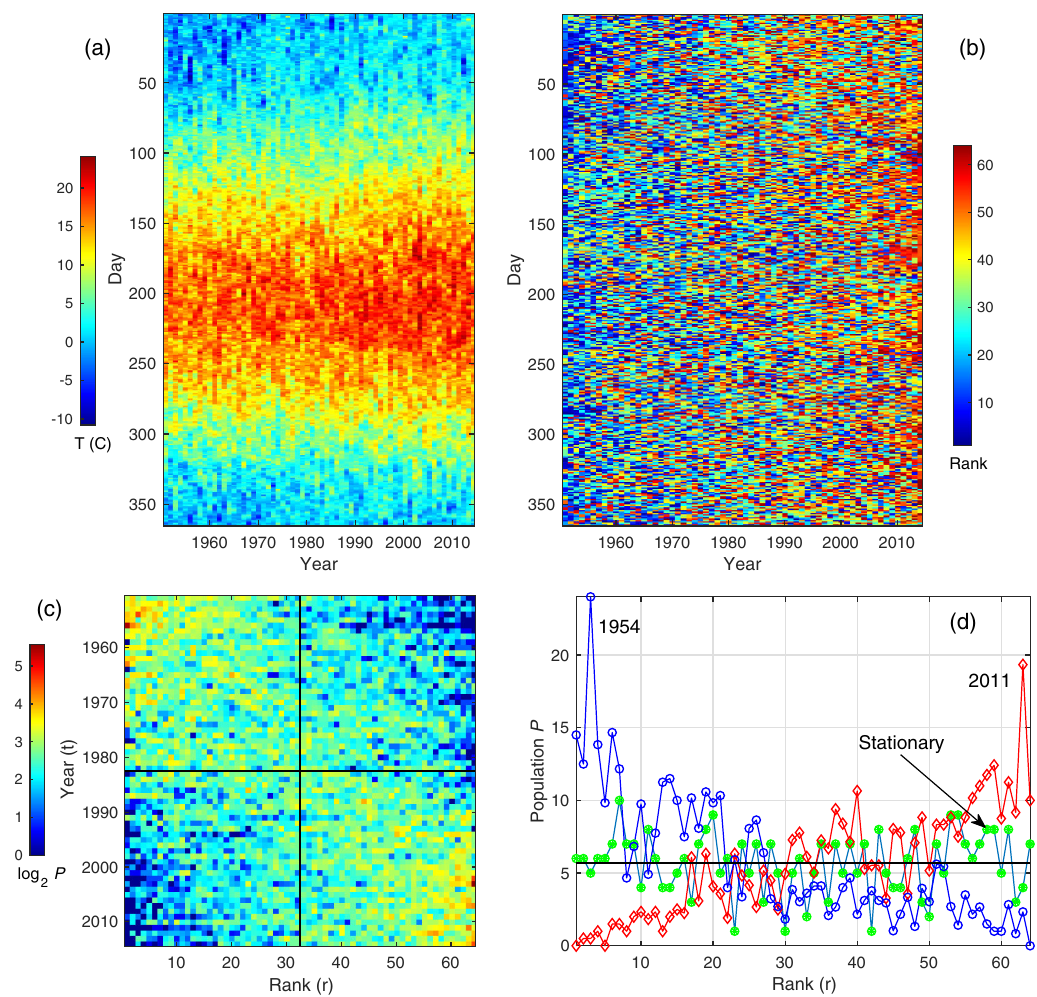
FIG. 1. Data processing, illustrated on weather station SZ000009480 (GHCN) Lugano, Switzerland. (a) Daily high-temperature values displayed as a day (row) and year (column) matrix. (b) Same data but with only the daily rank recorded in rows. (c) The 64 × 64 rank-year square matrix P , where each entry is the color-coded number of occurrences of that particular rank in that year ( “ occupation number ” ). The combined population of upper-left and lower-right quadrants (defined by the crosshairs) is 14 083, whereas the combined population of the lower-left and upper-right quadrants is 9277, with the expected population for stationary climate ð 365 × 64 Þ = 2 ¼ 11 680 . This quadrupolar asymmetry constitutes a warming signal. (d) 1954 and 2011 population vs rank. The near reflection symmetry between the red (diamond) and blue (circle) curves is evident and compatible with warming, with 75% of the 1954 population in the bottom half of ranks and 75% in the top half for 2011. The 1954 and 2011 maxima are at ranks 3 and 63, respectively. Considering the mean of μ ¼ 365 = 64 ¼ 5 . 70 and the Poisson pdf (valid for iid climate, see text), 24 occurrences of rank 3 in the year 1954 are exceedingly unlikely for a stationary climate ( 7 × 10 − 7 ). On the other hand, the number of record highs in 2011 was 10, which is plausible (3%) for a stationary climate [occurring once also in the green (asterisk) curve, which is one realization of a stationary climate]. Hence, most of the essential information here is contained in the intermediate ranks. The argument is stronger yet for autocorrelated